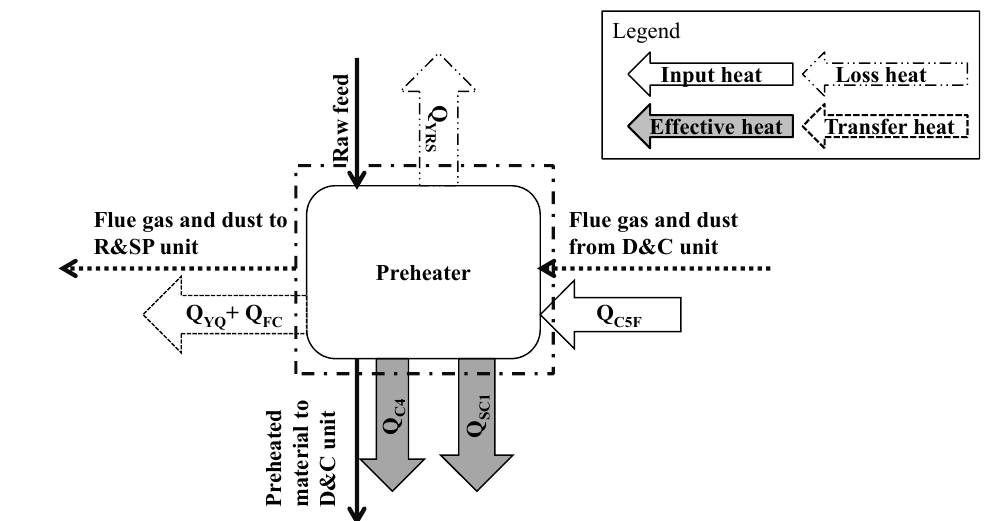
Figure 3. Heat flow modelling of the Preheating unit.